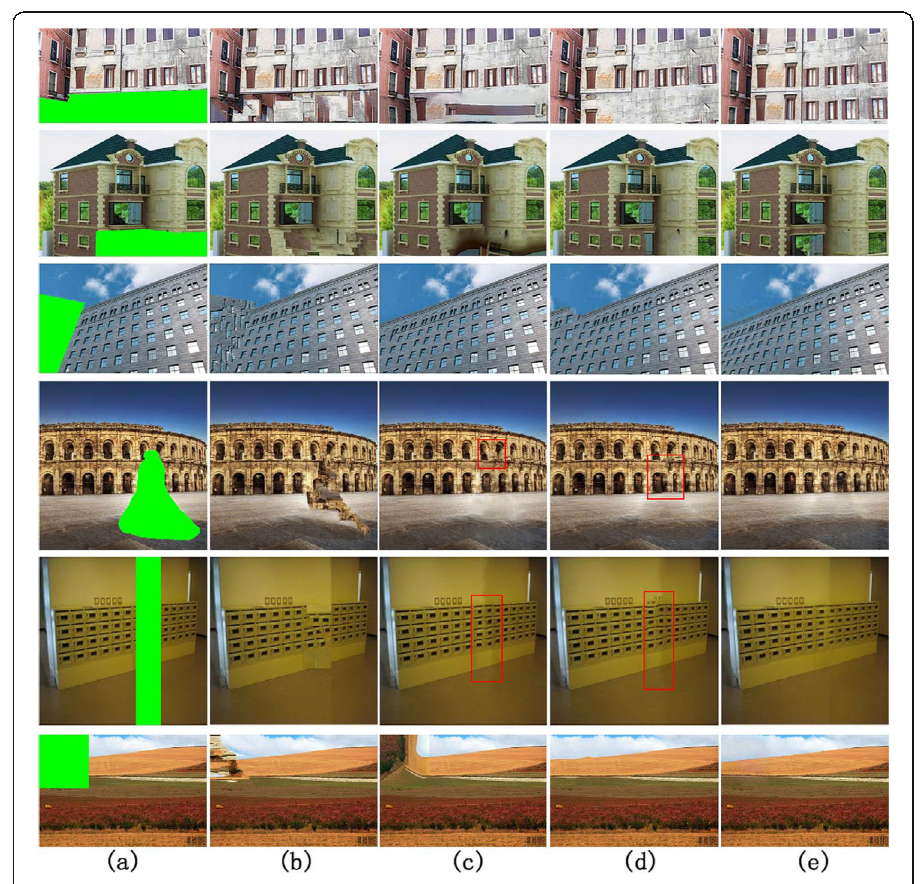
Fig. 5 Comparison results. a Input. b Criminisi ’ s result. c Image melding. d He ’ s result. e Our